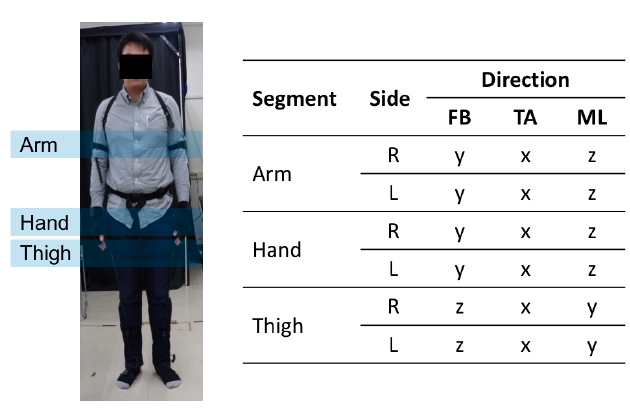
Figure 2. Target positions used in this study, FB: forward and backward, TA: toward and away, ML: medial and